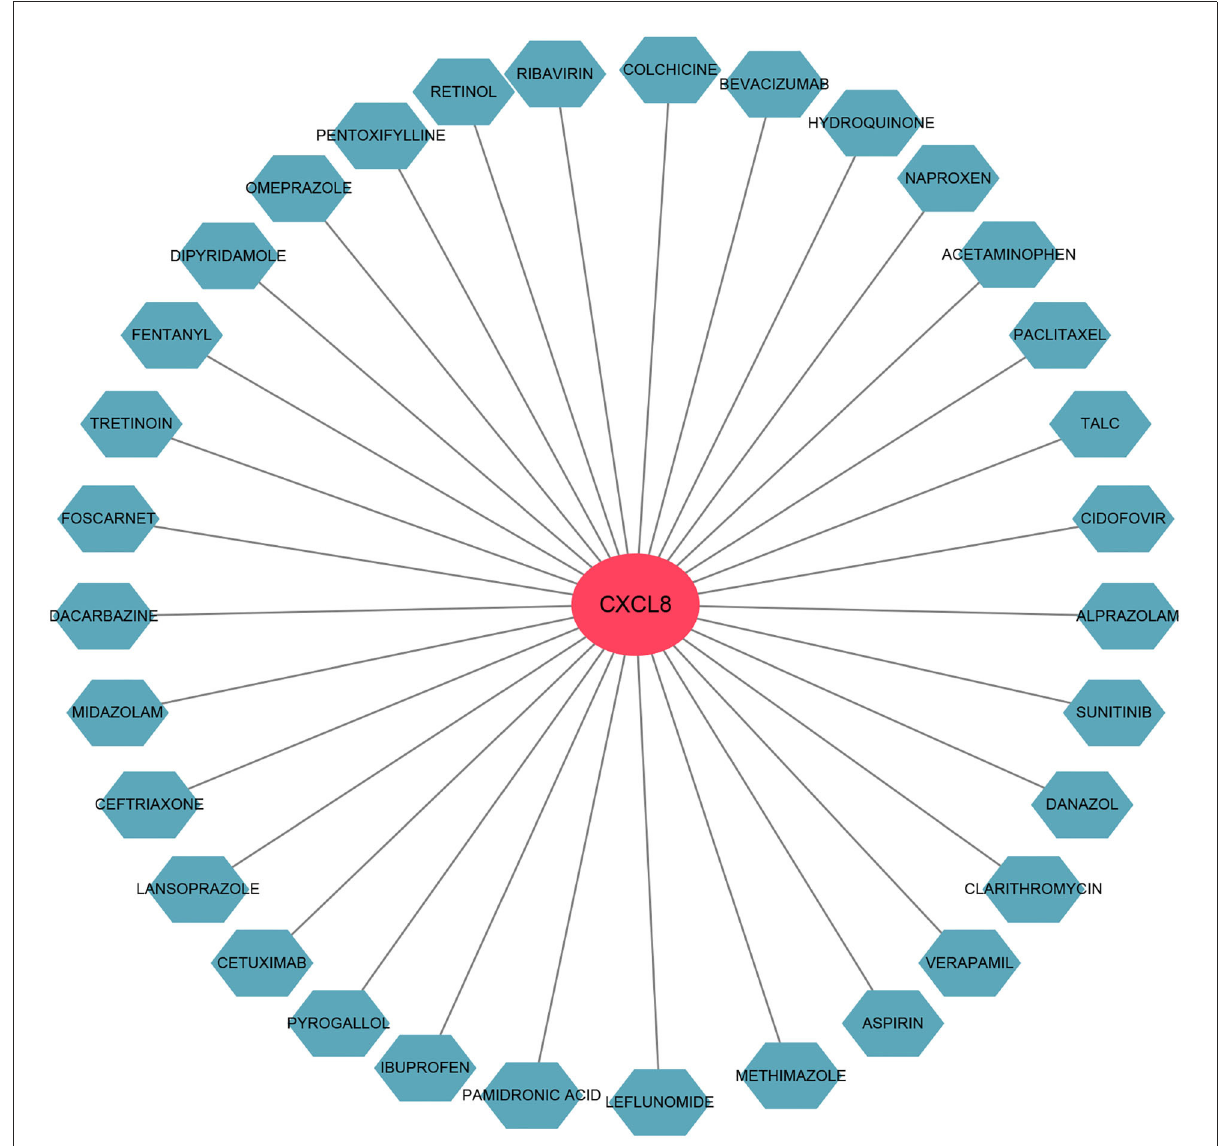
FIGURE9 The gene-drug interaction network. The red node represents the hub gene and ocean blue nodes represent